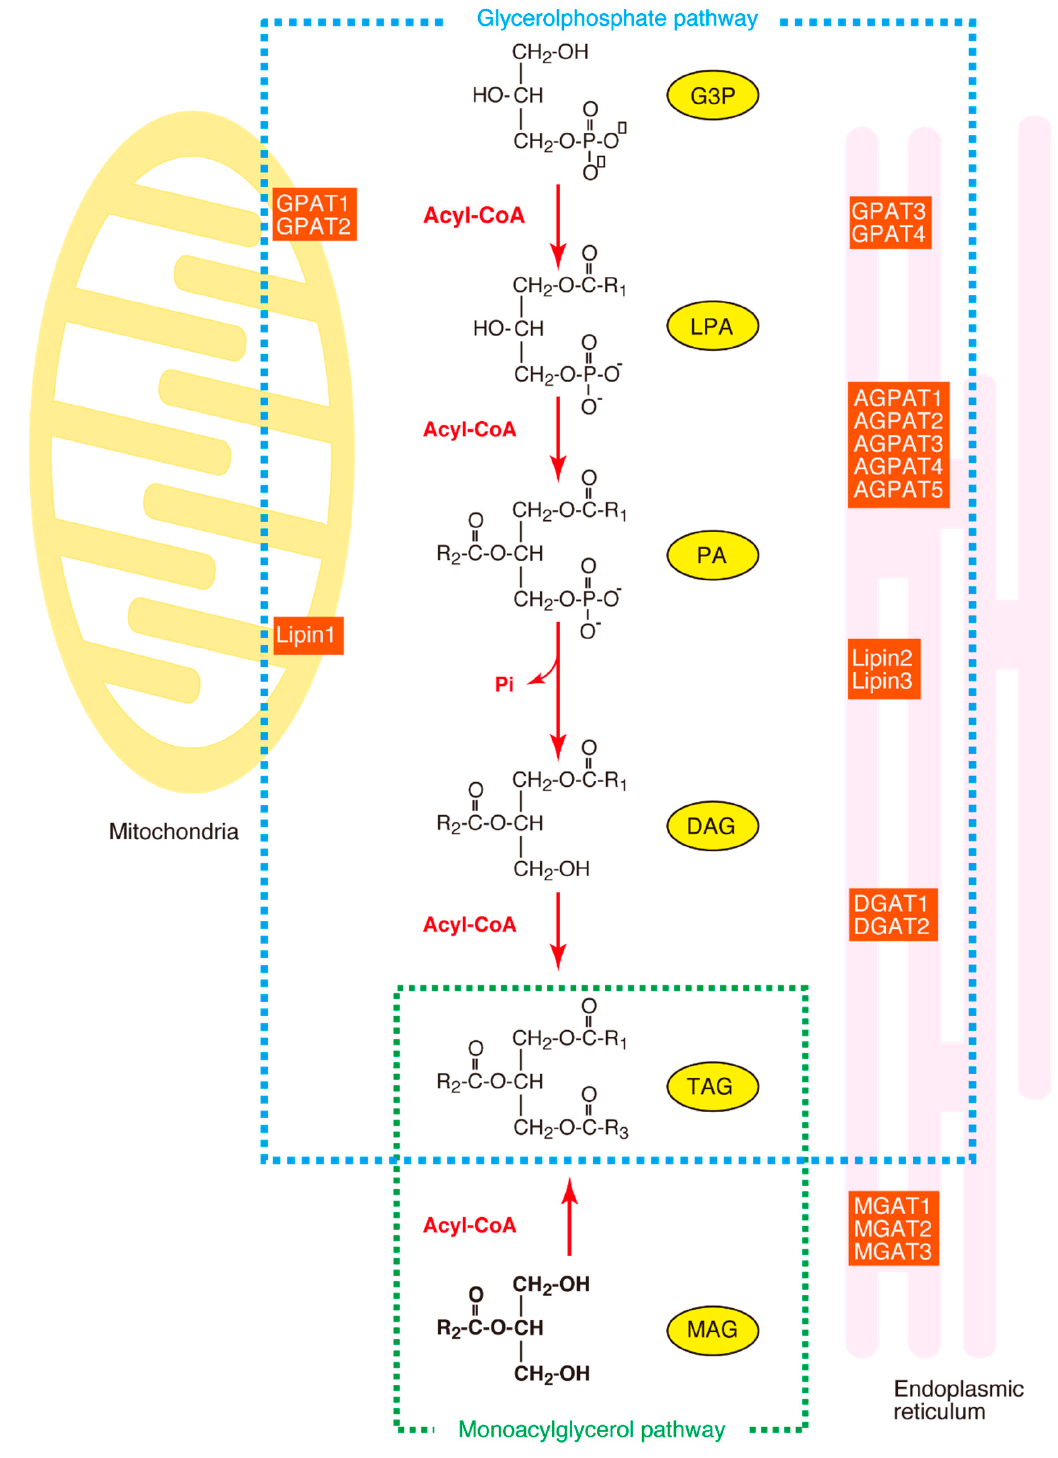
Figure 1. The synthesis of triacylglycerol (TAG). The glycerol phosphate pathway and the monoacylglycerol pathway are surrounded by dotted lines. MAG, monoacylglycerol; MGAT, monoacylglycerol acyltransferase; DHAP, dihydroxyacetone phosphate; DHAPT, dihydroxyacetone phosphate acyltransferase; DHAP-OR, dihydroxyacetone phosphate oxido-reductase; G3P, glycerol-3-phosphate; LPA, 1-acyl-G3P; PA, 1, 2-diacyl-G3P; DAG, diacylglycerol; GPAT, acyl-CoA:glycerol- sn -3-phosphate acyltransferase; DGAT, diacylglycerol acyltransferase; Lipin, phosphatidic acid